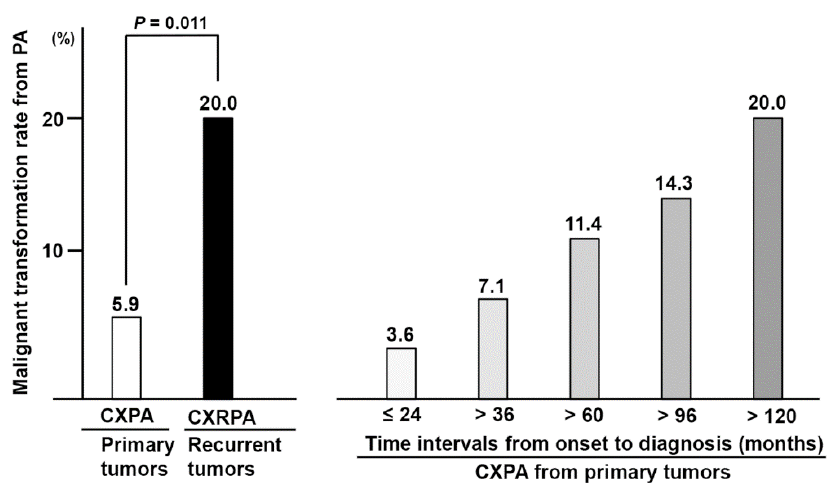
Figure 3. Overall incidence of malignant transformation arising from benign pleomorphic adenoma in our series. The malignancy rate (carcinoma ex pleomorphic adenoma) among the primary tumors was recalculated according to the incubation time (onset to diagnosis) intervals. CXPA, carcinoma ex pleomorphic adenoma; CXRPA, carcinoma ex recurrent pleomorphic adenoma.